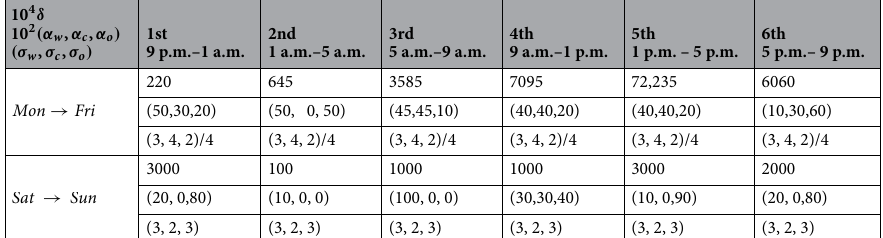
10 4 δ 10 2 (α w , α c , α o ) (σ w , σ c , σ o